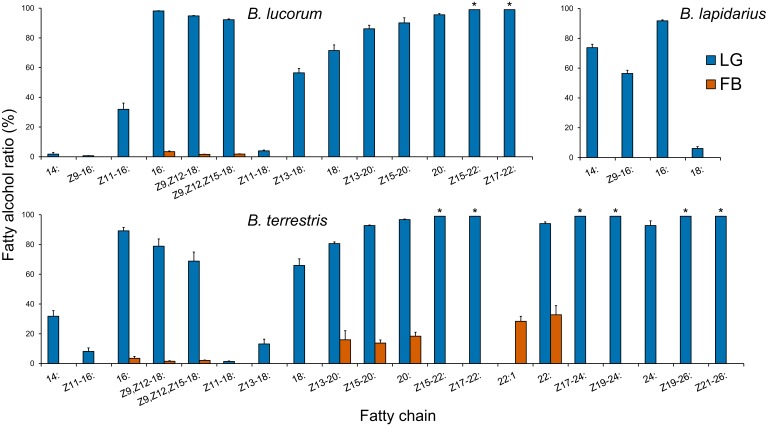
Apparent specificity of FARs in bumble bee LGs and FBs.The fatty alcohol ratios represent the apparent specificity of all putative FARs which are active in LGs and FBs of 3-day-old B. lucorum, B. terrestris and B. lapidarius (N = 3). Ratios >99%, suggesting high conversion rates of fatty acyl to fatty alcohol, are marked with an asterisk. In the case of 22:1 alcohols in FB of B. terrestris, the assignment of individual isomers was not possible due to their low amount, so they are counted as a sum of isomers. See Equation 1 for a description of fatty alcohol ratio calculation.